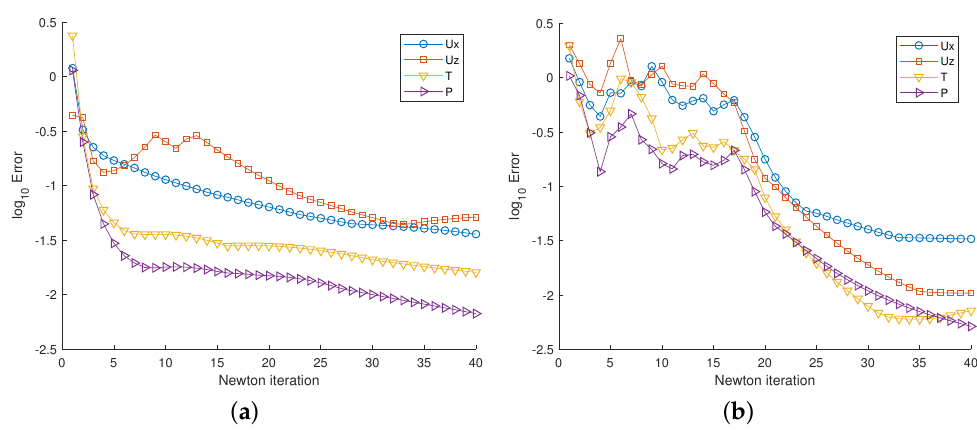
Figure 20. Graph of the log 10 of the errors in the velocity, temperature, and pressure fields for the Newton iterations: ( a ) R = 10 4 , Γ = 3.495, np = 25, mp = 2, N × M = 12 × 10; ( b ) R = 10 5 , Γ = 3.495, np = 25, mp = 5, N × M = 16 × 12.